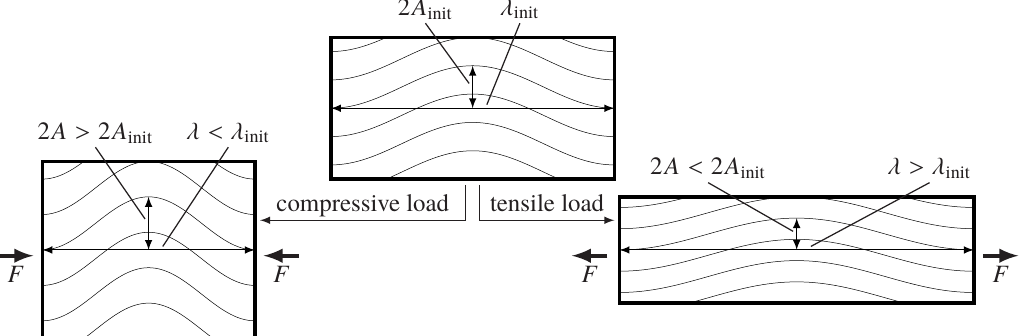
Figure 14. Schematic representation of the initial and deformed state of a wavy section and the corresponding change of the amplitude A and the wavelength λ in dependence of the applied load